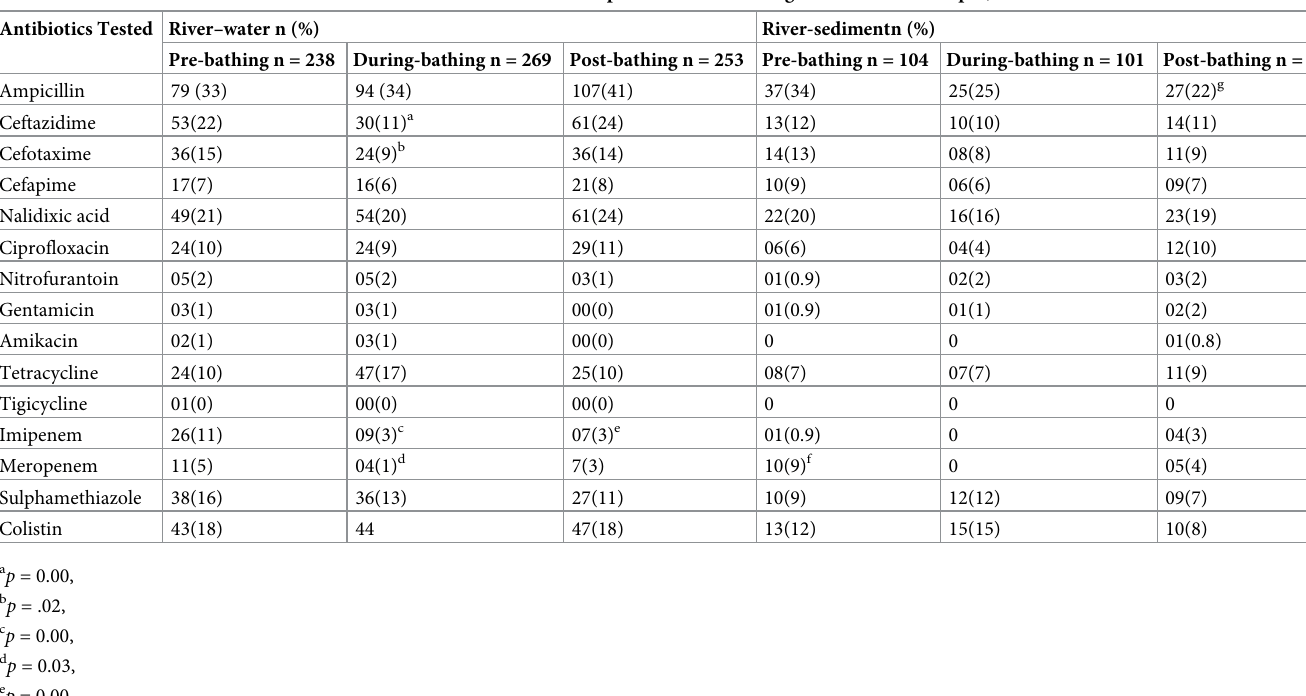
Table 4. Antibiotic resistance detected in E . coli isolated at different time points of mass bathing events in river Kshipra, Central India. Antibiotics Tested River–water n